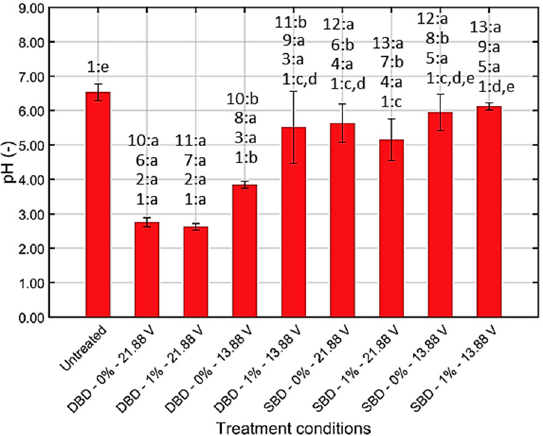
Figure 4. pH values (-) obtained following CAP treatment of 500 µL of sterile water using each possible combination of plasma characteristics ( n = 3). Significant differences between all examined conditions (ANOVA test 1), including the untreated control, have been indicated by means of a different small letter, with ‘a’ bearing the lowest value. The influence of the oxygen level (ANOVA tests 2–5), the electrode configuration (ANOVA tests 6–9), and the discharge power (ANOVA tests 10–13) on the pH of the CAP treated water have been indicated as well by means of a different small letter, with ‘a’ again bearing the lowest value.